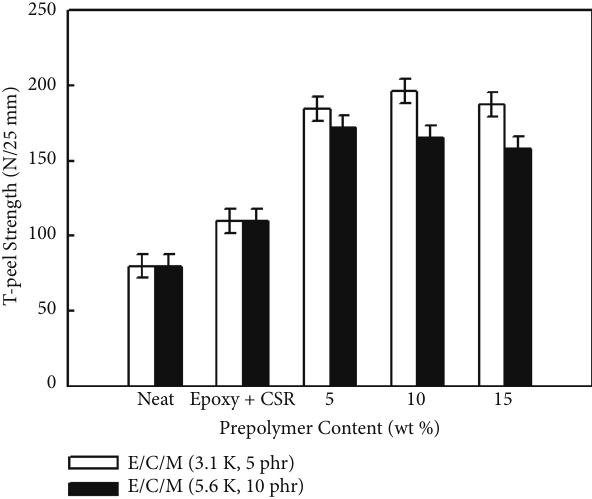
E/C/M (3.1 K, 5 phr) E/C/M (5.6 K, 10 Figure 5: Comparison plot of T-peel strength between E/C/M (3.1 K) and E/C/M (5.6 K) epoxy resins using di ff erent MPB wt%.